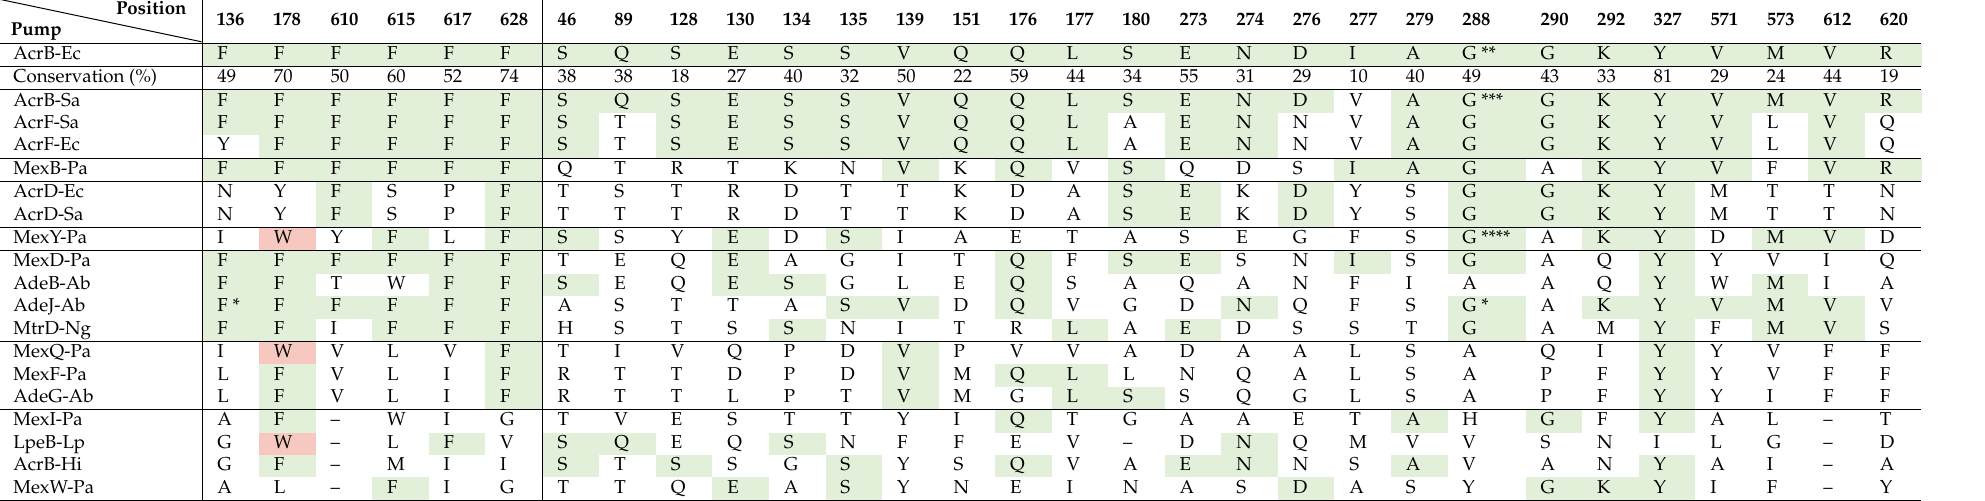
Table 5. Overview of residues of interest in the DBP area of 19 selected RND-type MDR transporters, and conservation among 135